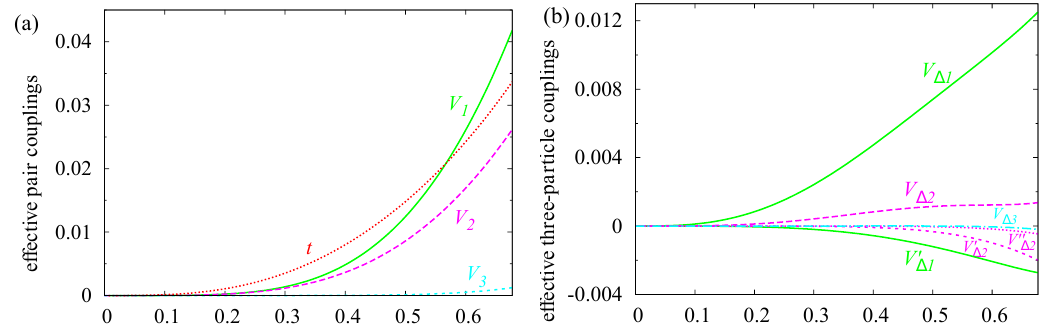
Figure 7: The effective pair (a) and three-particle (b) couplings (6) normalized with respect to the intradimer interaction J as a function of the ratio of the coupling con- stants J (cid:48) / J . The correlated hopping term is shown in panel (a) as a dotted line together with the effective pair